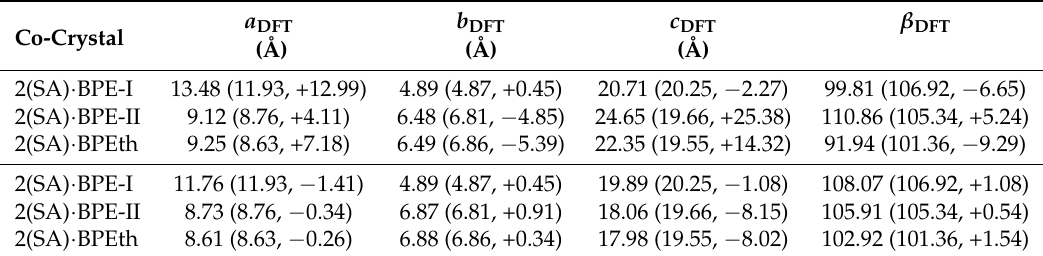
Table 6. Lattice parameters of co-crystals using DFT (top) and DFT-D (bottom). All lattice constants are reported in units of Åand % deviation from experimentally determined values are given in parentheses after the experimentally determined